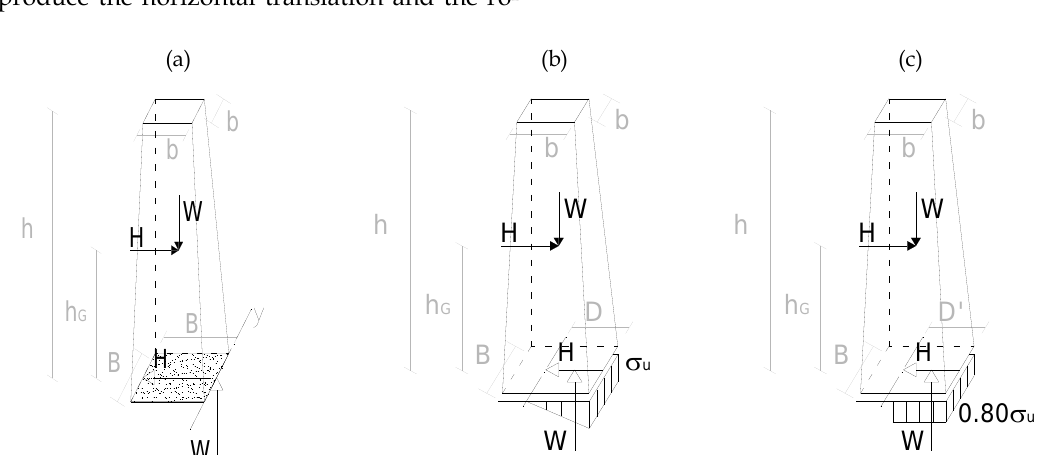
Figure 3 . Approach n°1 (a) and n° 2, corresponding to the onset of the yielding (b) and to the collapse (c) of the